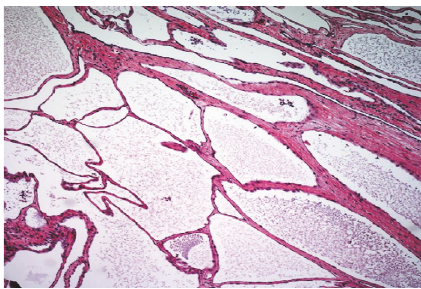
Figure 2: Cyst lining composed of single layer of mesothelial cells (H&E